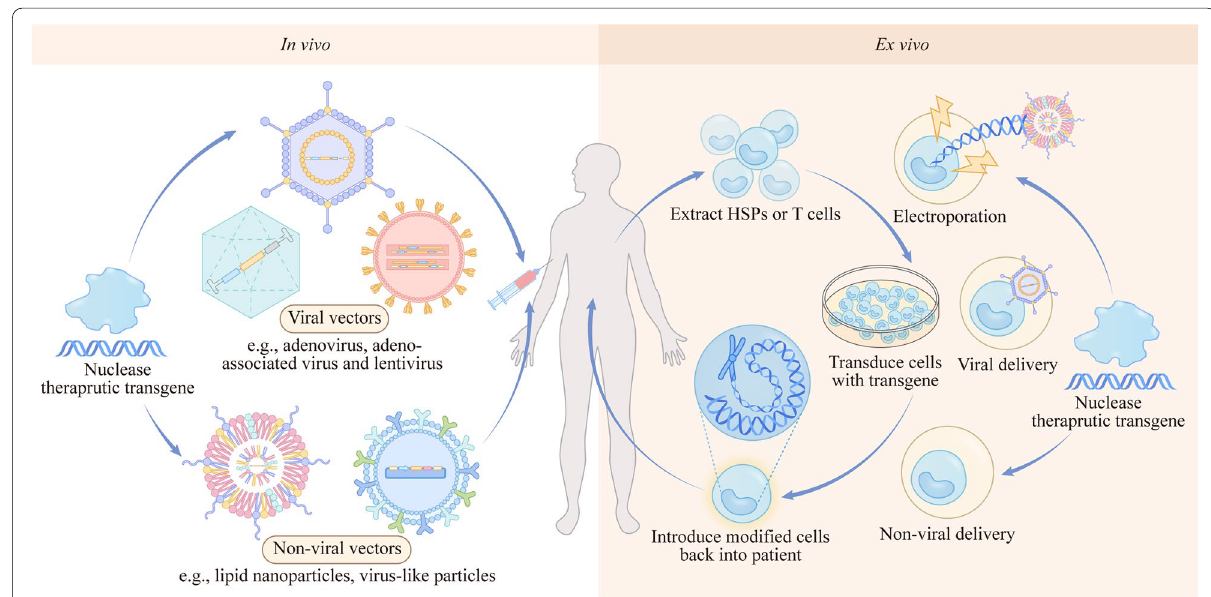
Fig. 3 Ex vivo and in vivo strategies for therapeutic CRISPR genome editing. Ex vivo and in vivo strategies for therapeutic CRISPR genome editing. For ex vivo strategies, HSPs or T cells are extracted from patients, deliver the nuclease and therapeutic transgene to the cells by electroporation, viral vector or non-viral vector, then transduce cells with transgene and introduce modified cells back into